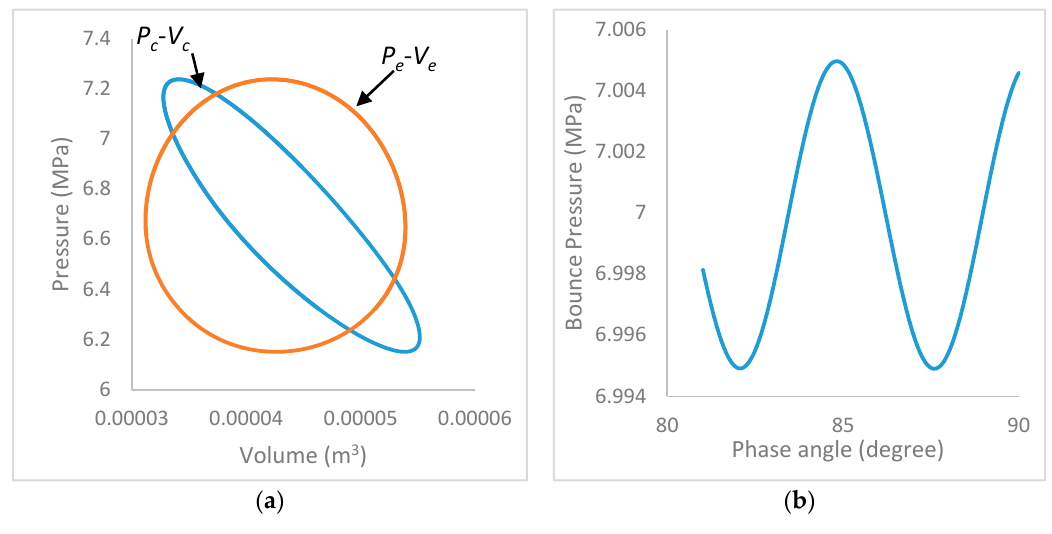
Figure 5. ( a ) Pressure to volume diagram; ( b ) Bounce pressure against phase angle.